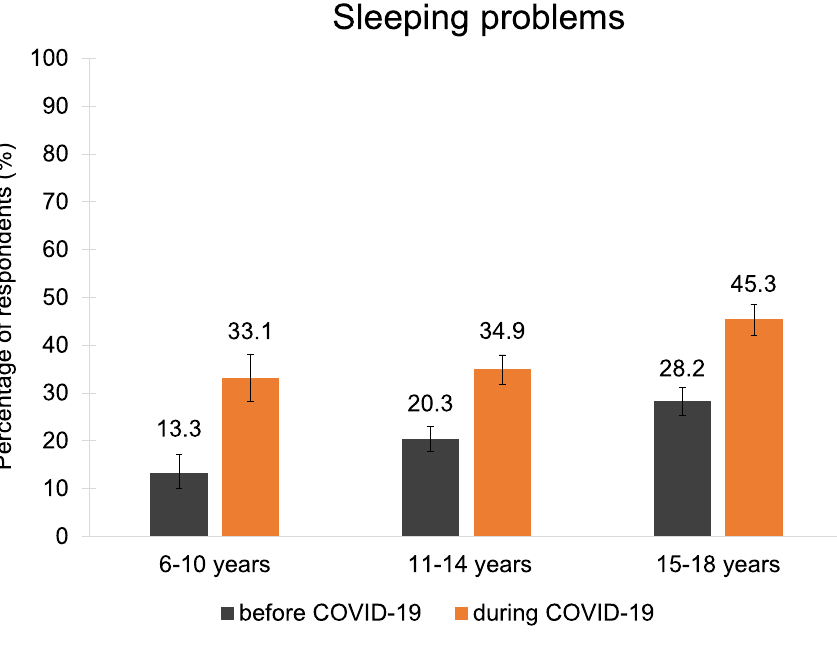
Figure 4. Change in sleeping problems. Children and adolescents reported almost twice as many (M = 1.9 times as much) sleeping problems during COVID-19 compared to before.